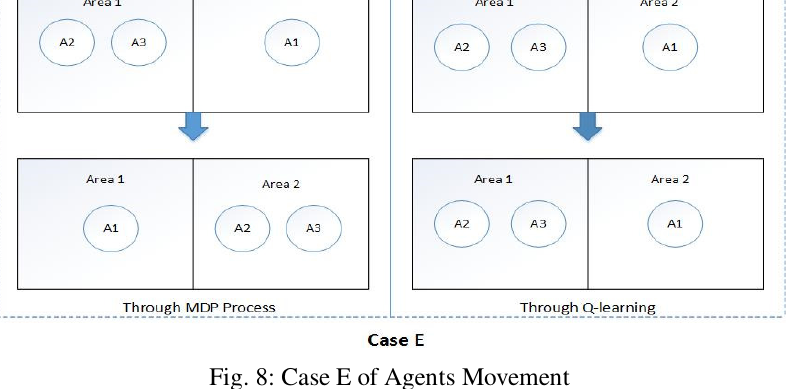
Fig. 8: Case E of Agents Movement